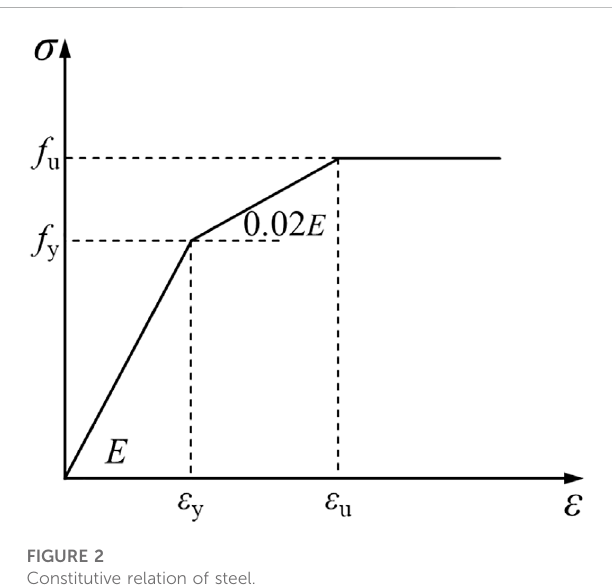
Constitutive relation of